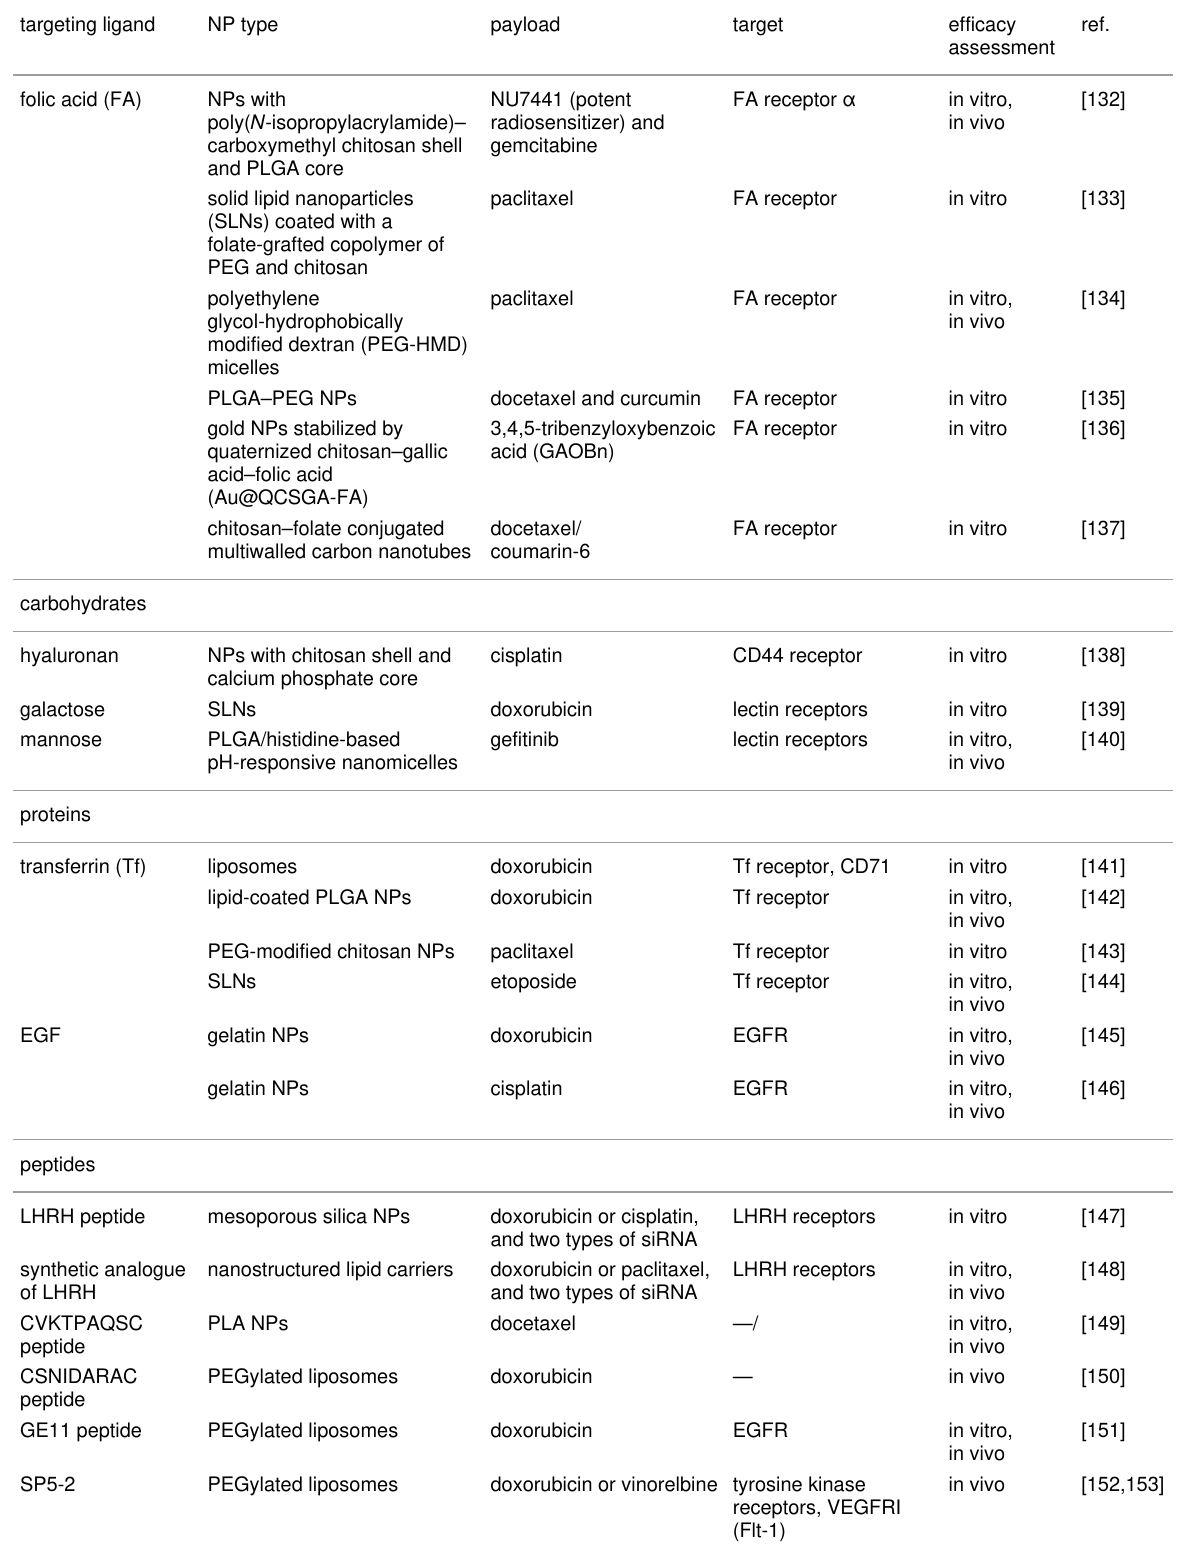
Table 2: NDDSs in molecular targeting of solid tumors sorted by targeting ligands. targeting